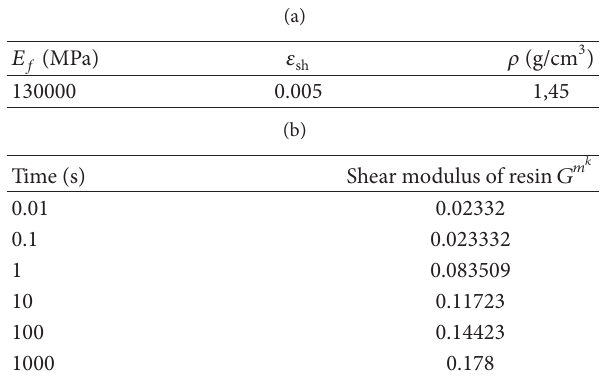
F 13: �oad force versus displacement for different �bre